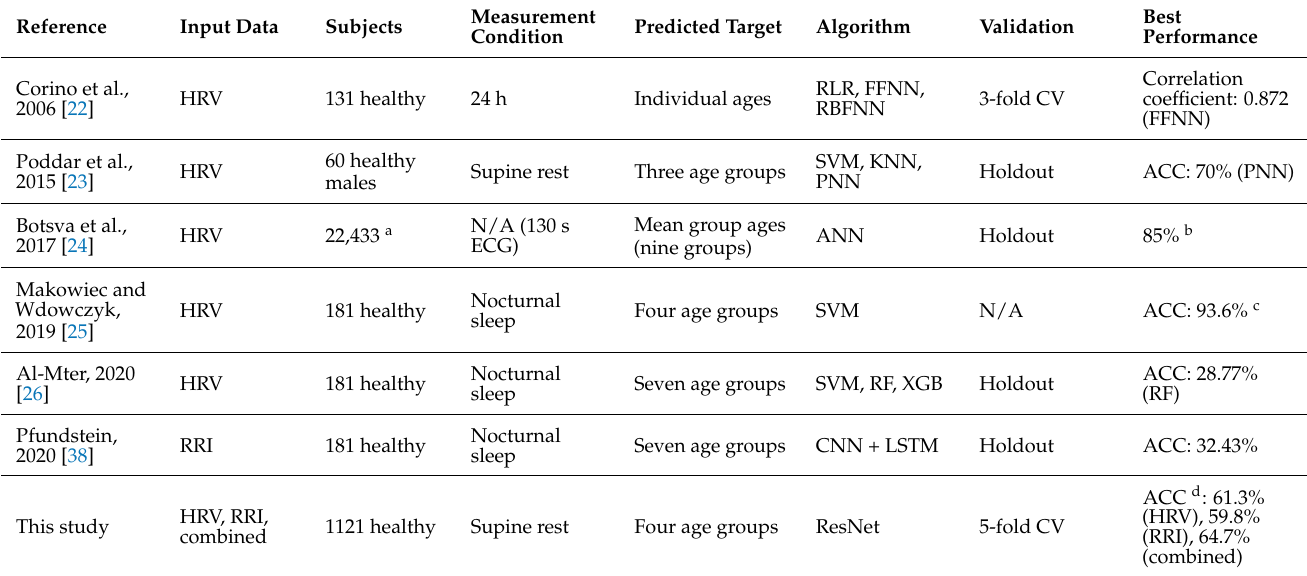
Table 13. Summary of machine learning-based age prediction using HRV and